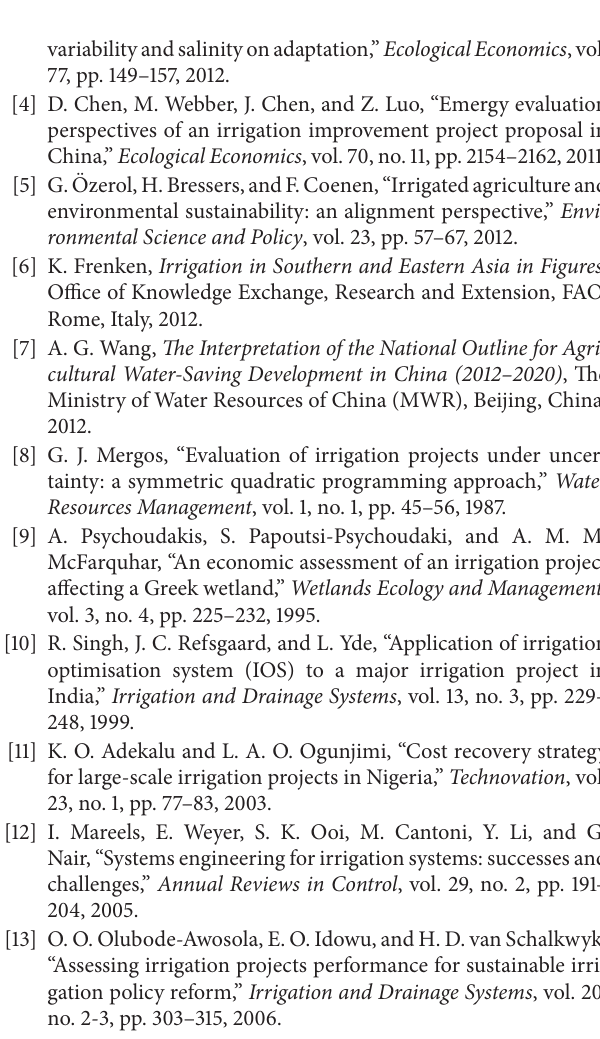
Number Emergy indices and